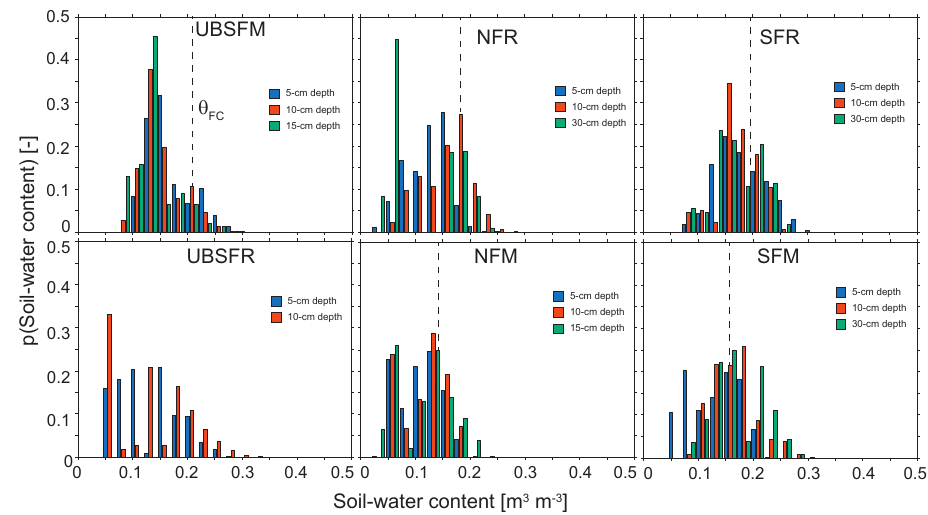
Fig. 8. Probability histograms of automated soil-water content data from the Decagon 5TE sensors.